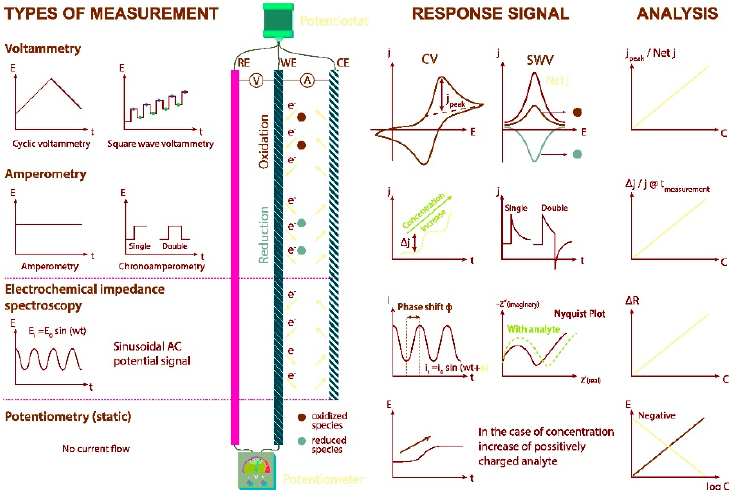
Figure 1. Overview of electrochemical methods of analysis: voltammetry, amperometry, electrochemical impedance spectroscopy (EIS), and potentiometry [19] .